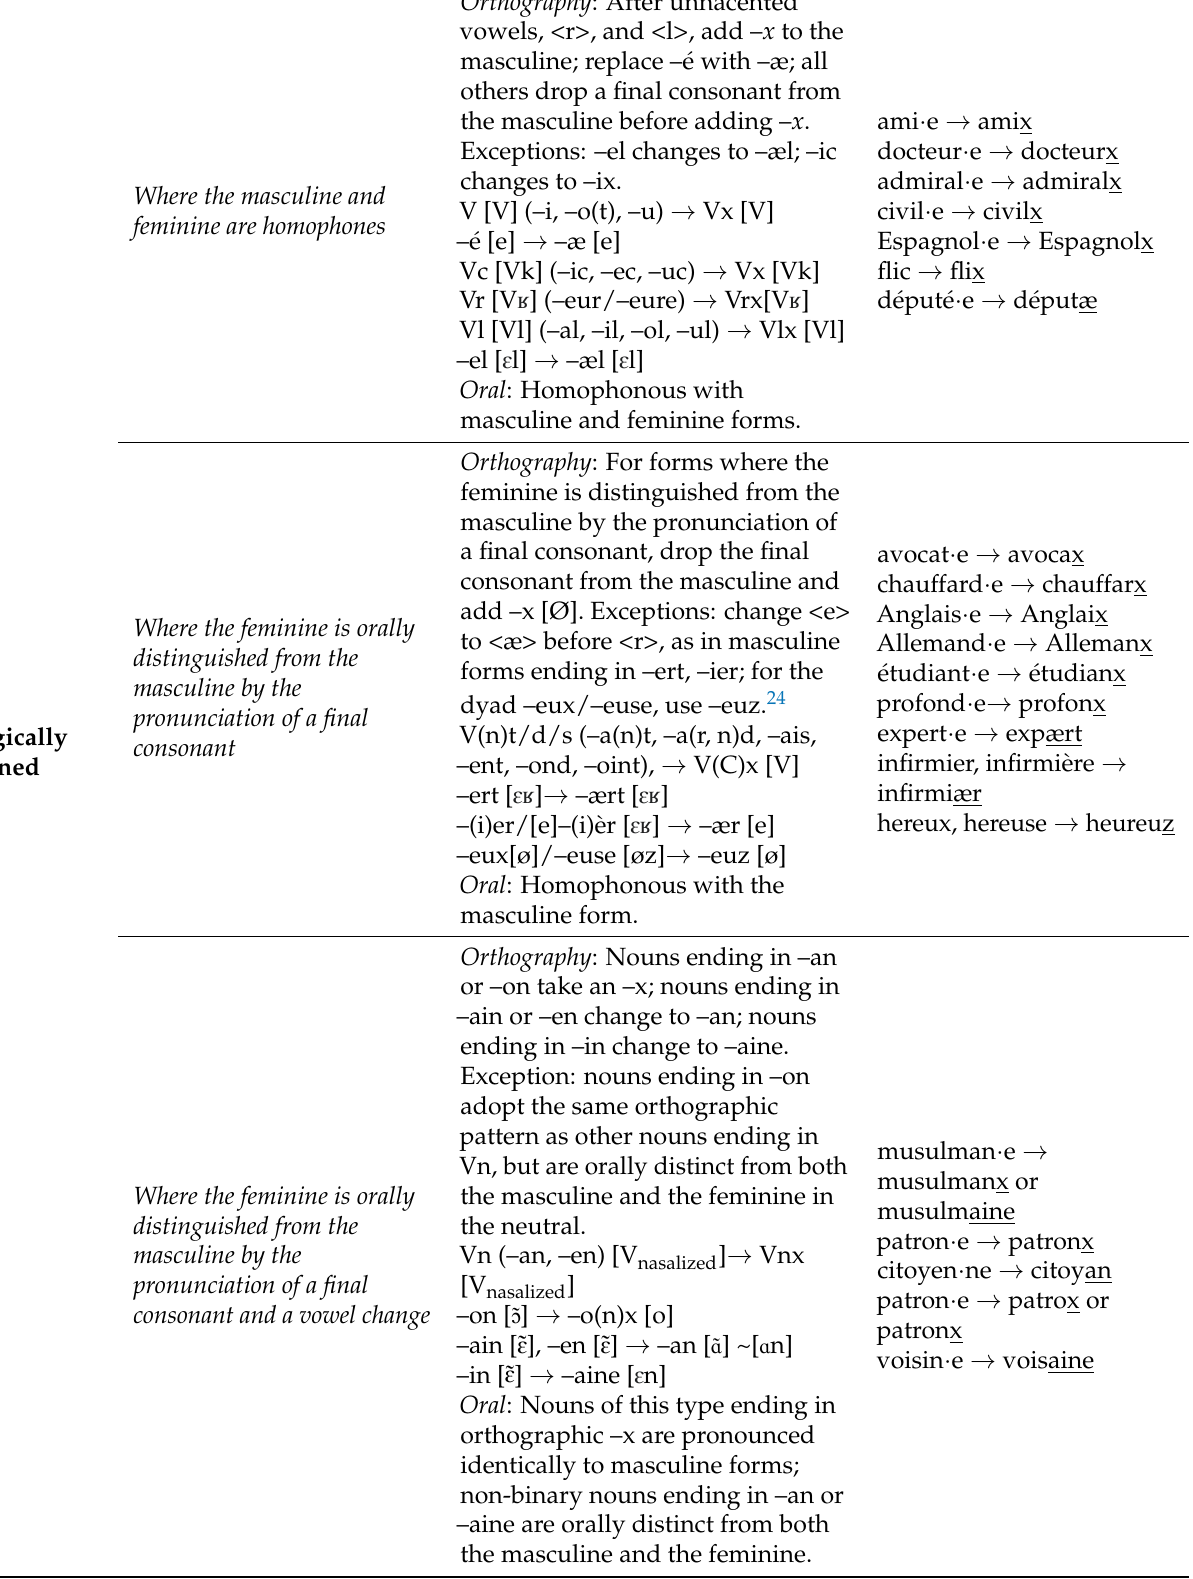
Table 1. Gender and Number Distinctions in Written and Oral French.